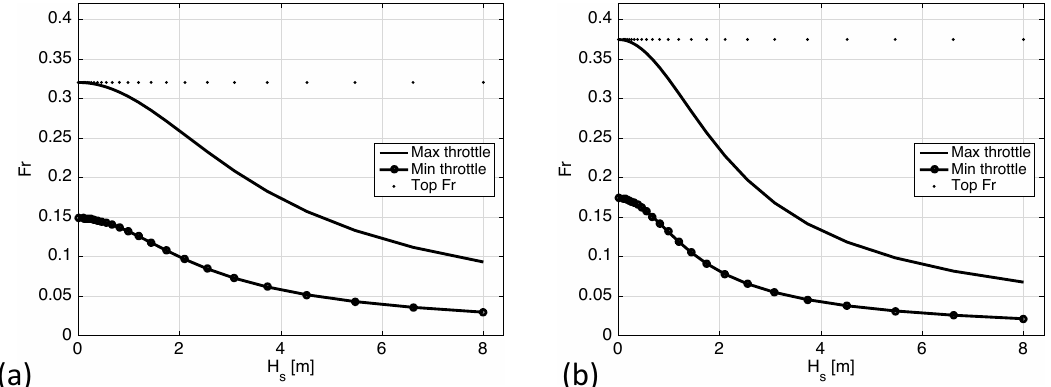
Figure 4. Sustained Froude number Fr at a constant engine throttle vs. significant wave height H s . Both the cases of maximum (solid line) and minimum (line and dots) throttle of Table 3 are displayed. Panel (a) and (b) refers to ship parameters for vessel V1 and V2 in Table 5,